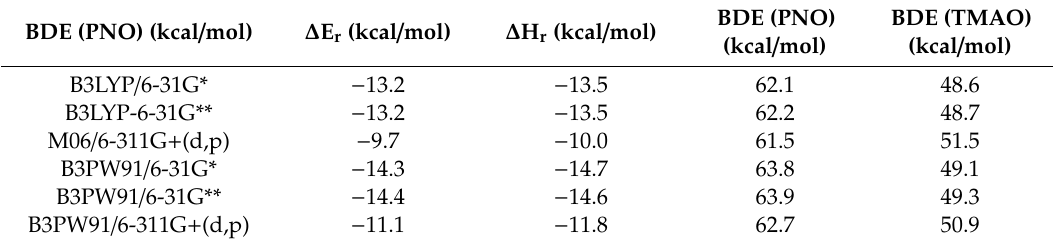
BDE (PNO) BDE (TMAO) (kcal / mol) (kcal / mol)